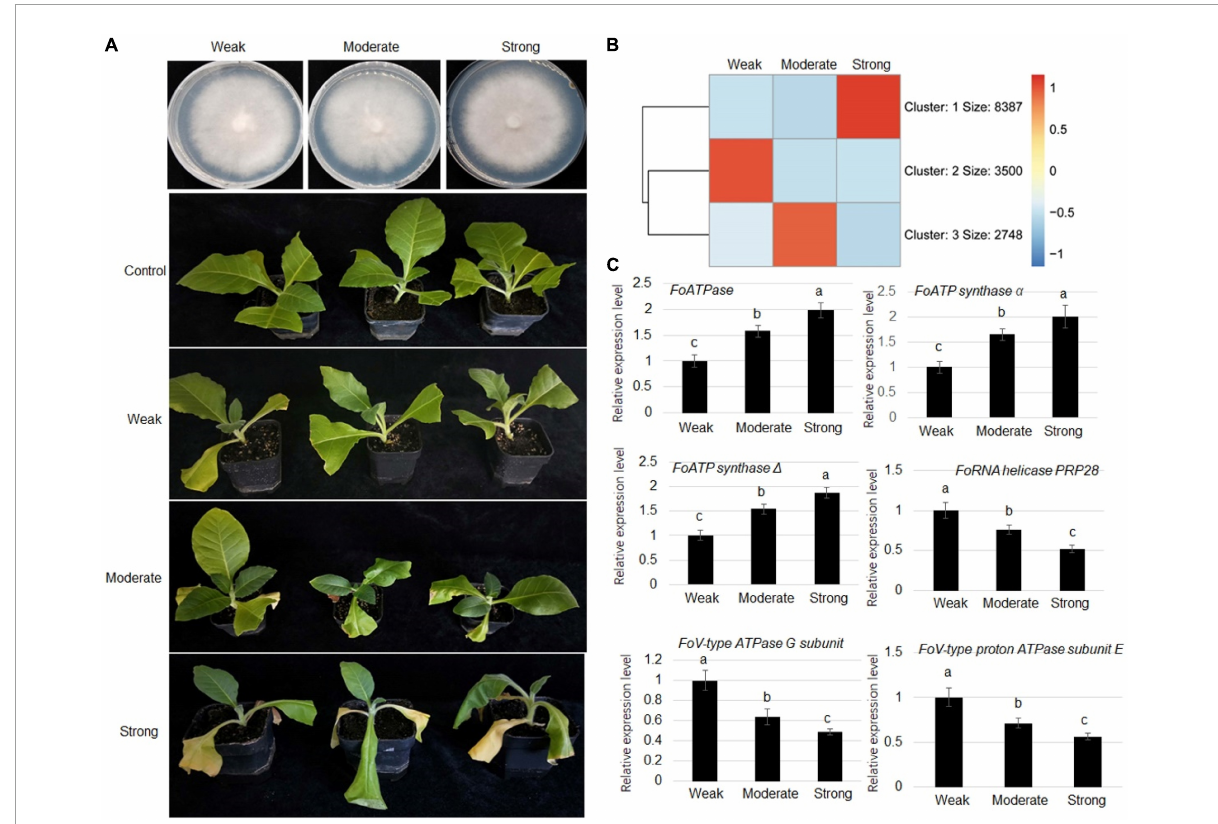
FIGURE2 Comparative transcriptome analysis of Fusarium oxysporum strains displaying three levels of virulence (weak, moderate, and strong). (A) Representative images of three types of virulence Fusarium oxysporum strains grown on PDA medium. (B) Representative images of tobacco plants inoculated with Fusarium oxysporum strains displaying weak, moderate, or strong virulence, as indicated, toward tobacco plants. (C) Heat map of genes that are differentially expressed in Fusarium oxysporum strains displaying three levels of virulence. (D) Comparison of the expression levels of FoATPase , FoATP synthase α , FoATP synthase (cid:49) , FoRNA helicase PRP28 , FoV-type ATPase G subunit , and FoV-type proton ATPase subunit E in Fusarium oxysporum strains displaying different levels of virulence. Different letters above the bars indicate significant differences ( P <